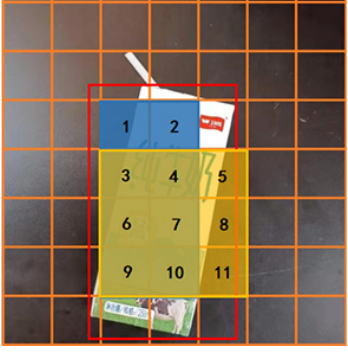
Figure 3. The positive sample region proposal.